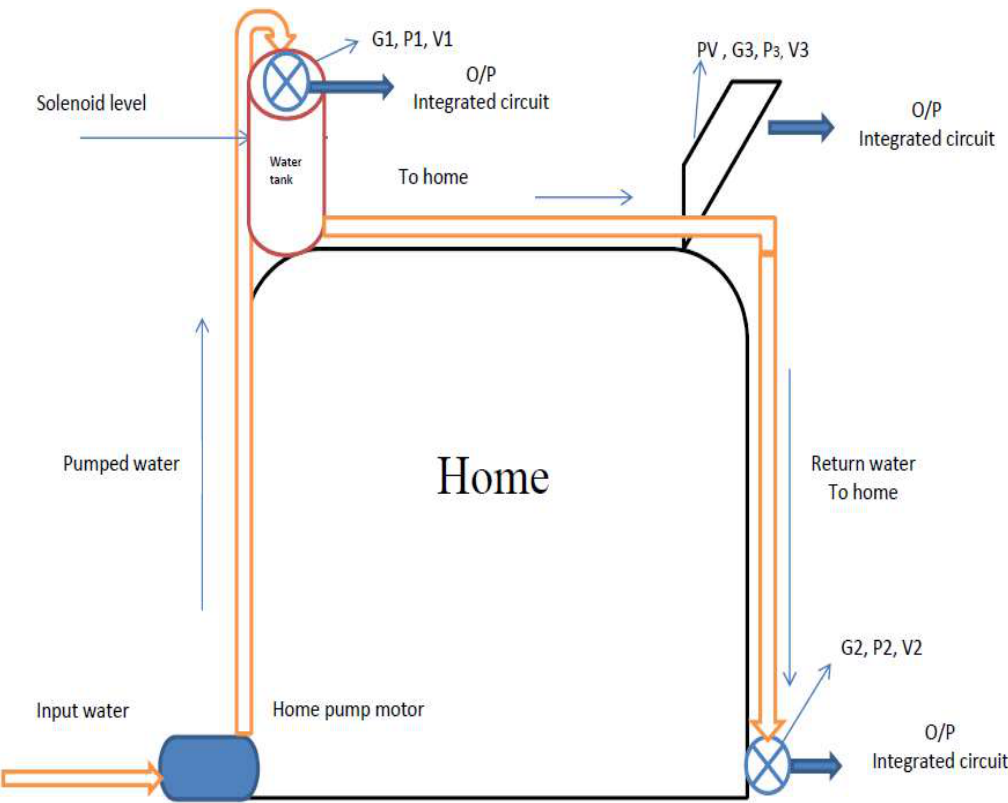
Figure 2. House generation systems places.